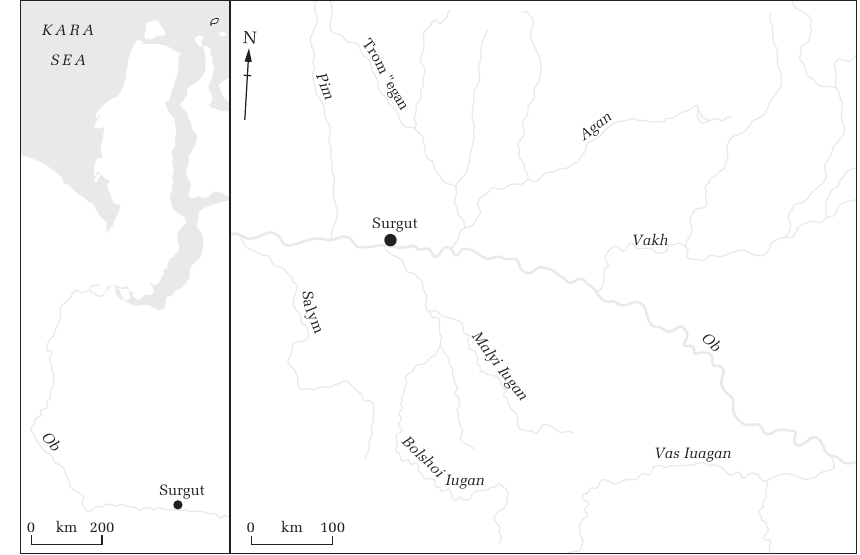
Figure 1 Western Siberia: the homeland areas of the eastern Khanty people are located on the eight named tributaries of the River